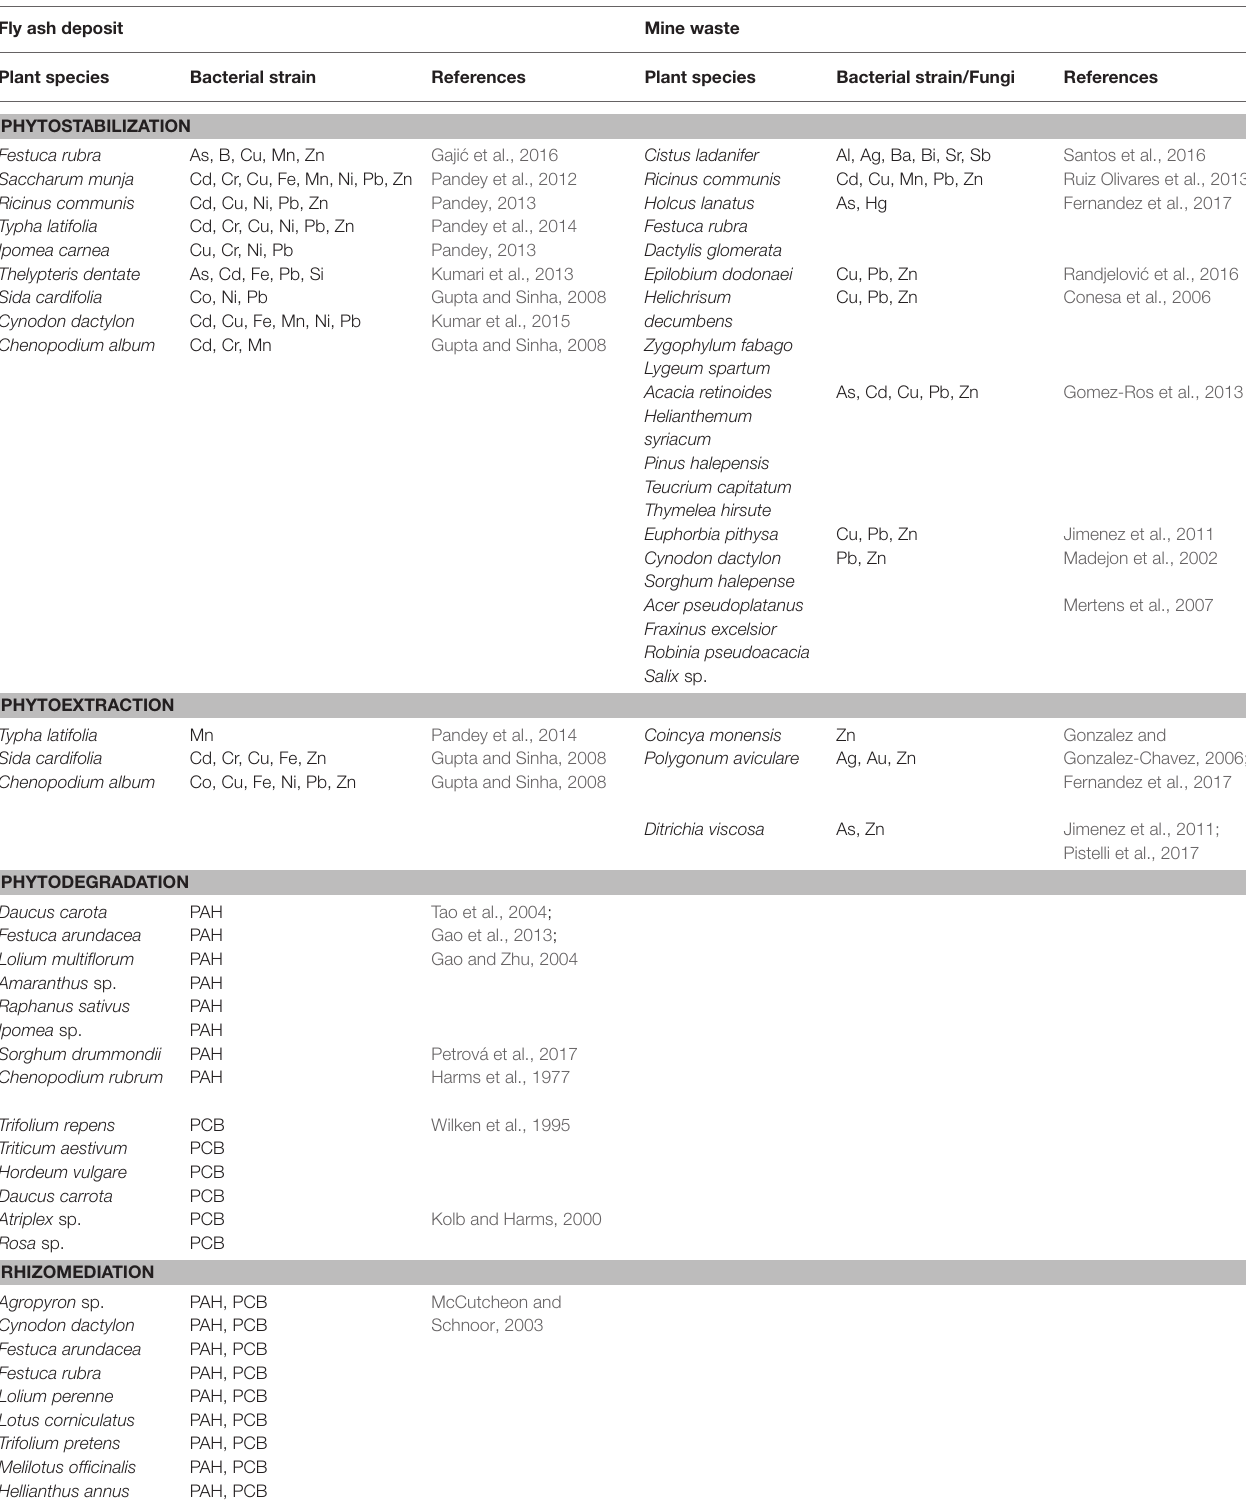
TABLE 3 | Plant species growing on fly ash deposits and mine waste with high potential for phytostabilization, phytoextraction, phytodegradation, and rhizomediation. Fly ash